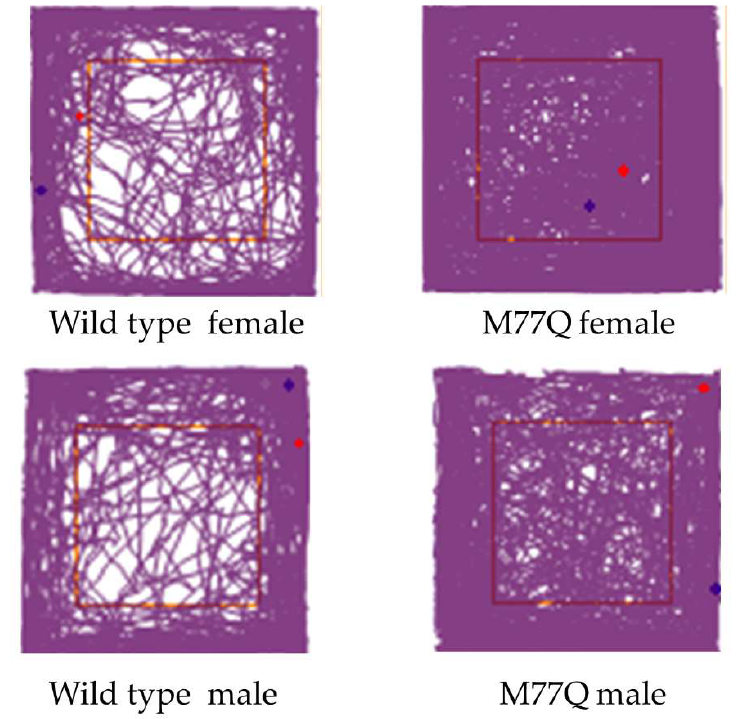
Figure 9. Track plots of mice during the open field test at 6 months of age.